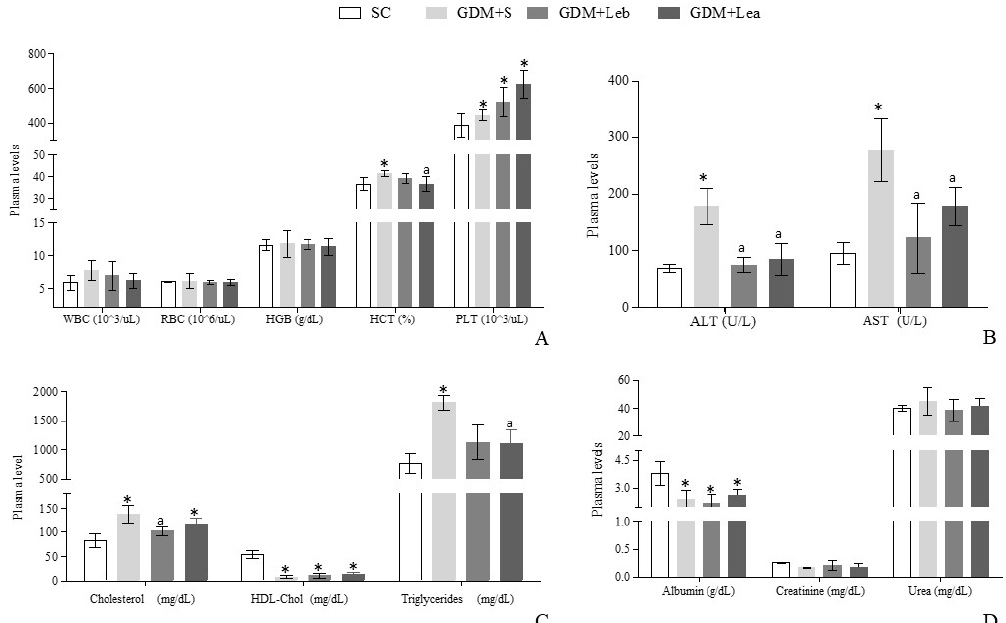
Figure 2. Hematological, hepatic, renal and lipid profiles outcomes of pregnant rats. ( A ) Hematological parameters. ( B ) Biochemical serum outcomes for hepatic analysis. ( C ) Lipidic profile. ( D ) Biochemical serum outcomes for renal analysis. SC (saline control 0.9%), GDM + S (diabetic + saline solution 0.9%),